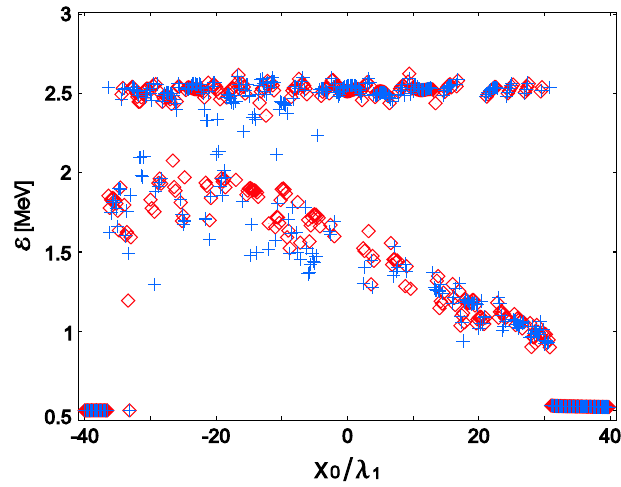
FIG. 5. Particle energy dependence on the initial longitudinal positions x 0 (normalized) at the reflection capture both by the plane (red small square symbols) and nonplane-focused (blue crisscross symbols) laser pulses under the same condition for ! 1 =! 2 ¼ 10 ; other parameters are defined in the text for Figs. 1 and 3.